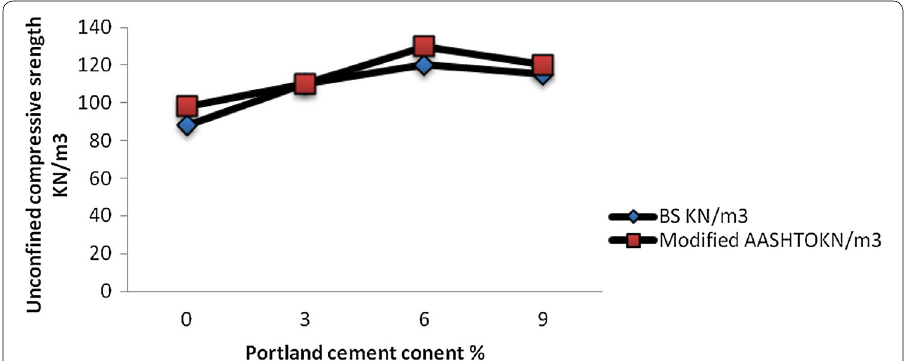
Fig. 5 Plots of unconfined compressive strength versus Portland cement